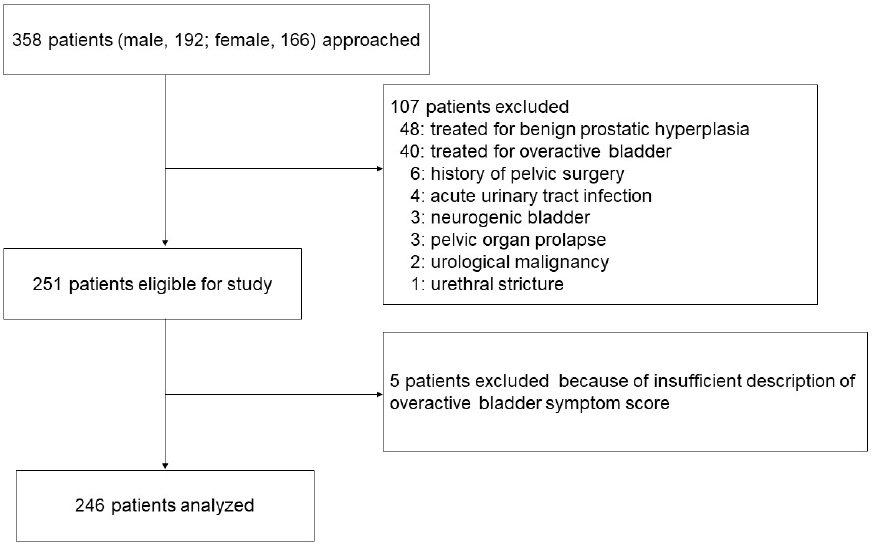
Figure 1. Patient flow diagram.